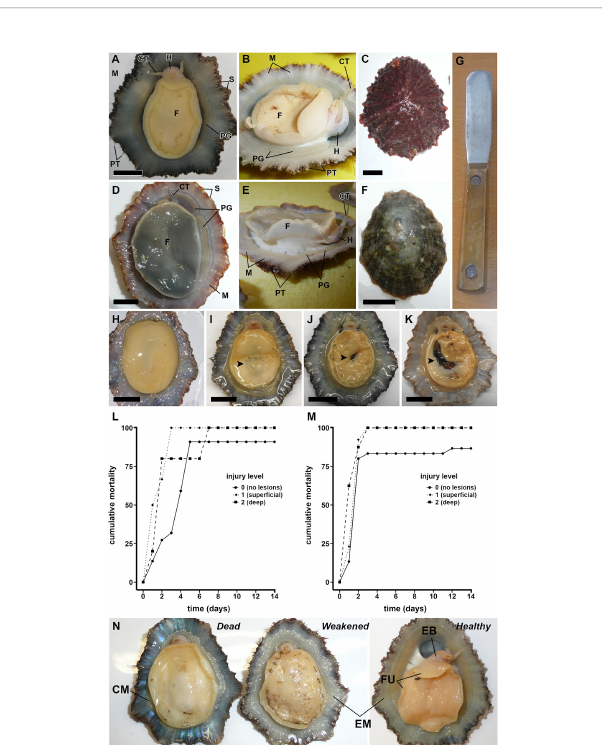
FIGURE 1 | Limpet species studied in the present study (A – F) . Patella aspera Röding, 1798 from Madeira (A – C) : ventral view (A) , lateral view (B) , and dorsal view of a shell covered by encrusting coralline algae (C) . Patella candei d ’ Orbigny, 1840 from Madeira (D – F) : ventral view (D) , lateral view (E) , and dorsal view of a shell with scarce epibionts (F) . Blunt knife known as “ lapeira ” used for the traditional fi shing of limpets (G) . Impact of physical damage on broodstock survival (H – M) . Category level of the physical injuries using P . aspera as example (H – K) : level 0, no visible injuries (H) ; level 1, super fi cial lesions (I) ; level 2, deep lesions (J) ; level 3, evisceration and/or decapitation (K) . Cumulative mortality during the fi rst 2 weeks after the capture (L, M) : P . aspera (L) and P . candei (M) . Health condition of the specimens using P . aspera as example (N) . Scale bar = 10 mm. CM, contracted mantle; CT, cephalic tentacles; EB, extended body; EM, extended mantle; F, foot; FU, foot undulations; H, head; PG, pallial gills; PT, circumpallial tentacles; S,